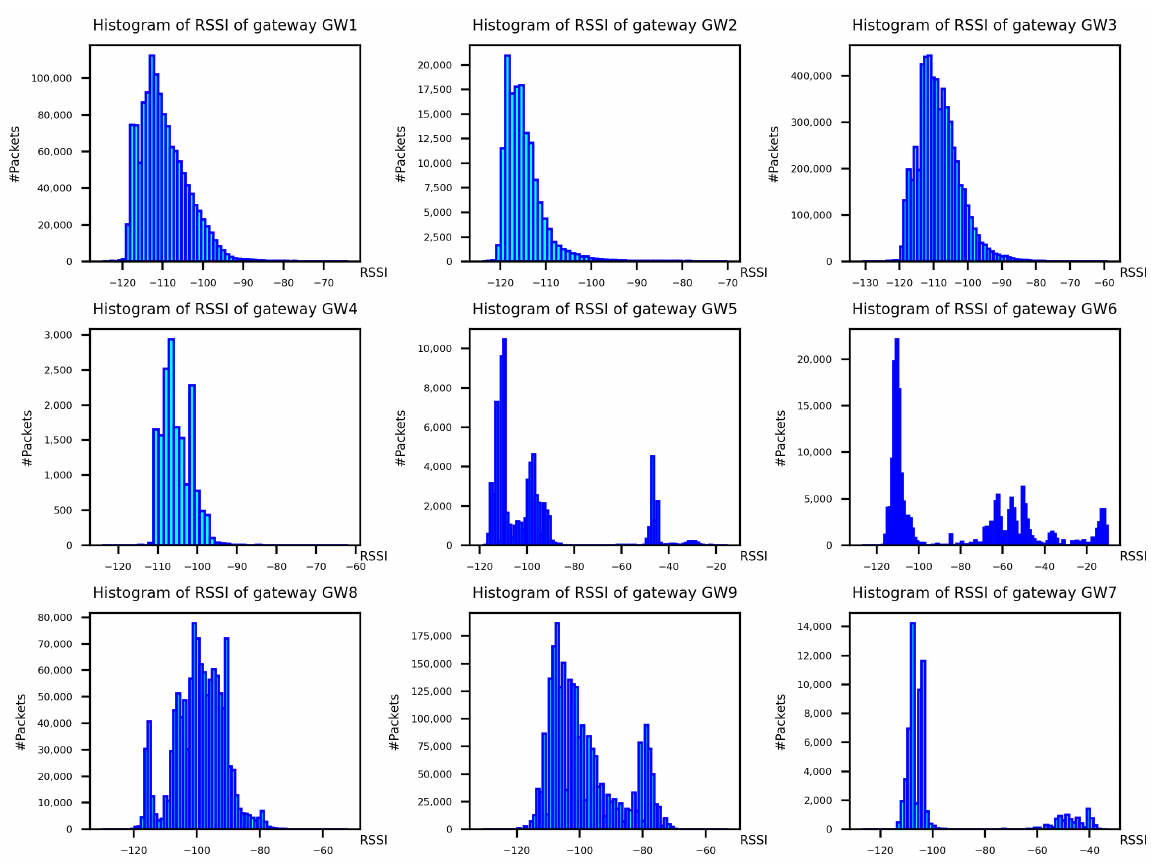
Figure 6. Histogram of RSSI per